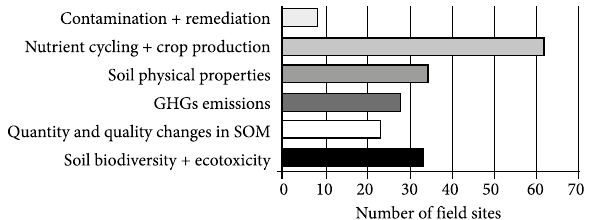
Fig. 7. Number of field sites that monitor variables related to the COST Action thematic groups (see Table